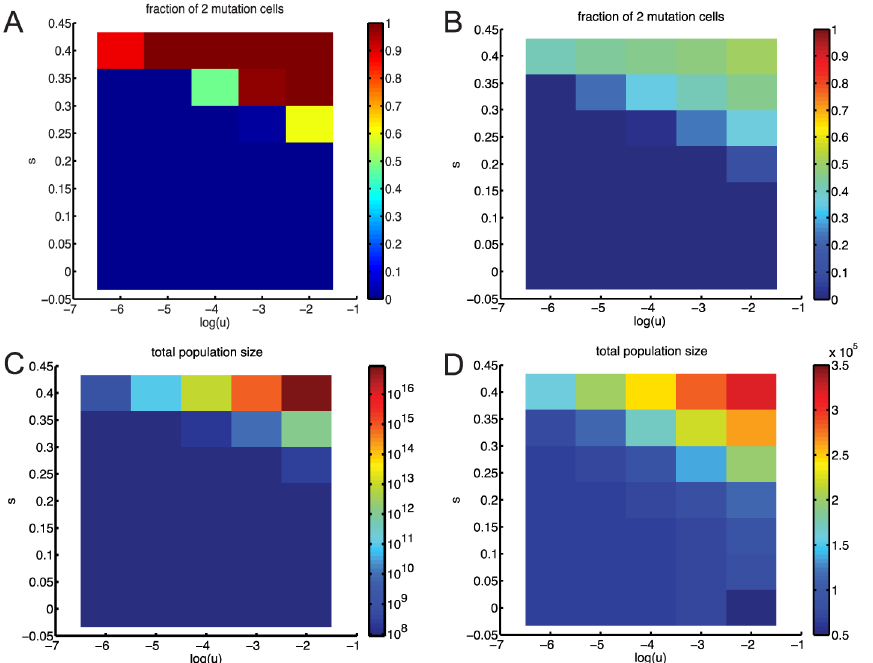
Figure 2. Steady-state progenitor distributions in the absence of stem cell mutation. (A, B) Fraction of two-mutation cells as a function of mutation rate u and proliferative advantage s for (A) unlimited growth, (B) logistic growth for each subpopulation. (C, D): Corresponding total population sizes for (C) unlimited growth, (D) logistic growth. Birth/death rates of progenitor cells are given by Eq. (5) with constant death rate m ~ 1 and sigmoidal birth rate with maximal growth rate b 0 ~ 2 , b i ~ (1 z s ) b i { 1 for i ~ 1,2 . In (B) the carrying capacity used is N 1 ~ 200 N sc , N 2 ~ 250 N sc , N 3 ~ 300 N sc : Other parameters are as in Table 1. For two-mutation cells to reach appreciable levels in this scenario, both the mutation rate and the proliferative advantage must be unreasonably large.